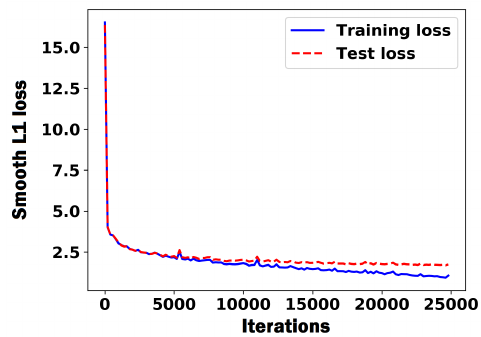
Figure 7. Plot of the smooth L 1 loss of the CNN regression model during training process. The unit of the loss is